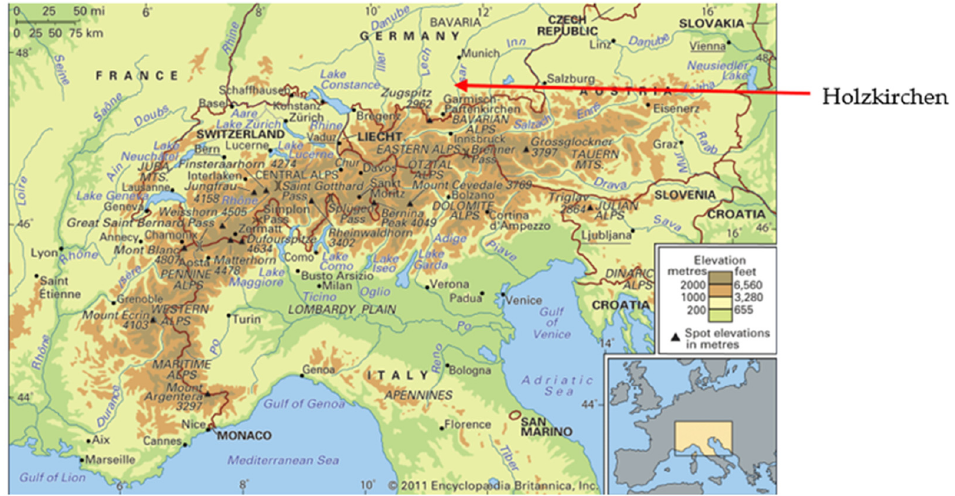
Figure 8. Holzkirchen map (sourced from https://www.britannica.com/place/Alps) (accessed on 1 June 2022).